Question: Condense the content of this figure into a single sentence.
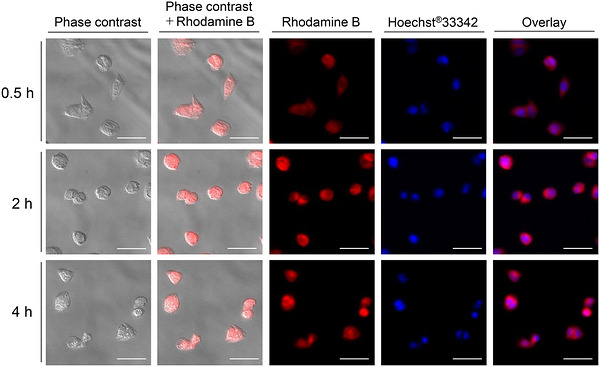
Answer: Cellular uptake of Rhodamine B‐labeled PSBMA‐ARTs conjugates. Scales bar = 50 µm.